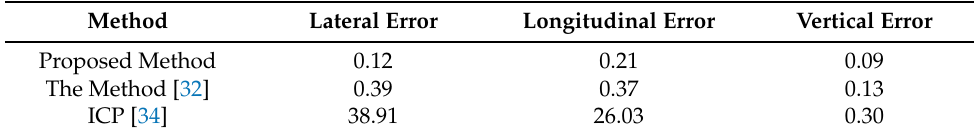
Table 3. Errors of Registration Under Different